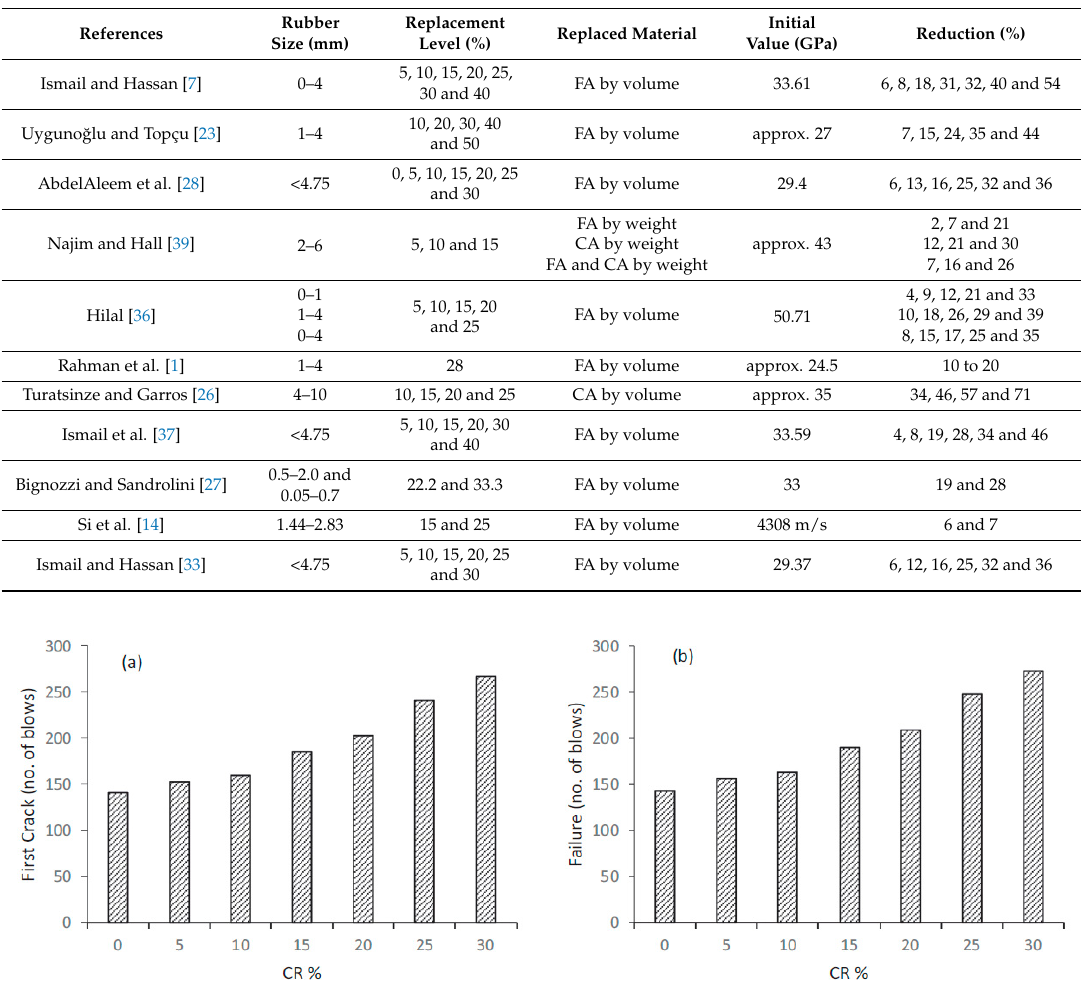
Figure 5. Impact resistance of self-compacting rubberized concrete under drop weight test: ( a ) effect of crumb rubber on N1; ( b ) effect of crumb rubber on N2 [28]. Reproduced with permission from B.H.